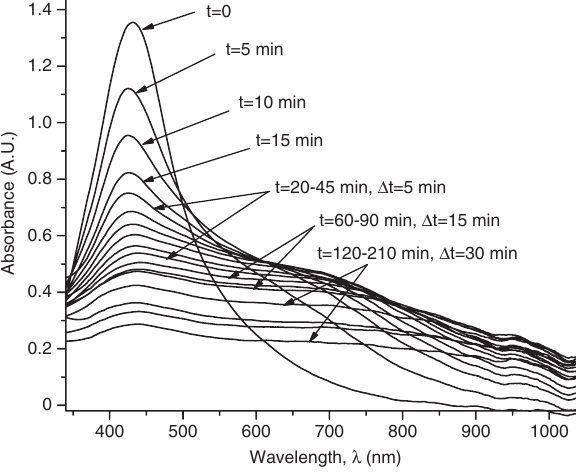
Figure 11 Absorption spectra of AgNPs before and after irradiation (5-min interval). [AgNPs] – 1.94 × 10- 4 mol/l (Ag 0 ), [NaNO